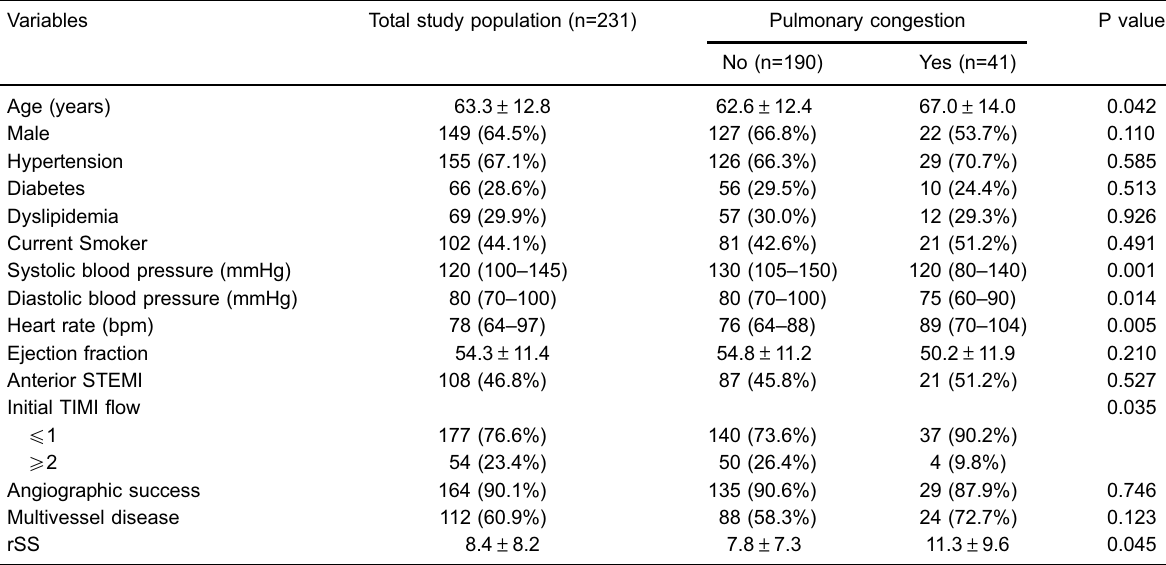
Table 1. Baseline clinical and angiographic characteristics of the entire study population according to pulmonary congestion.